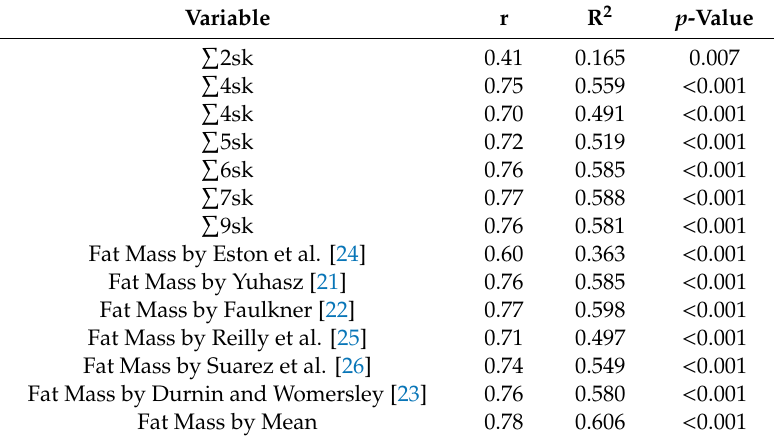
Table 2. Correlation coe ffi cients and level of significance between fat mass percentage (FM%) estimated by dual-energy X-ray absorptiometry (DXA) with the sum of skinfold measurements, and FM% obtained from skinfold-based equations.